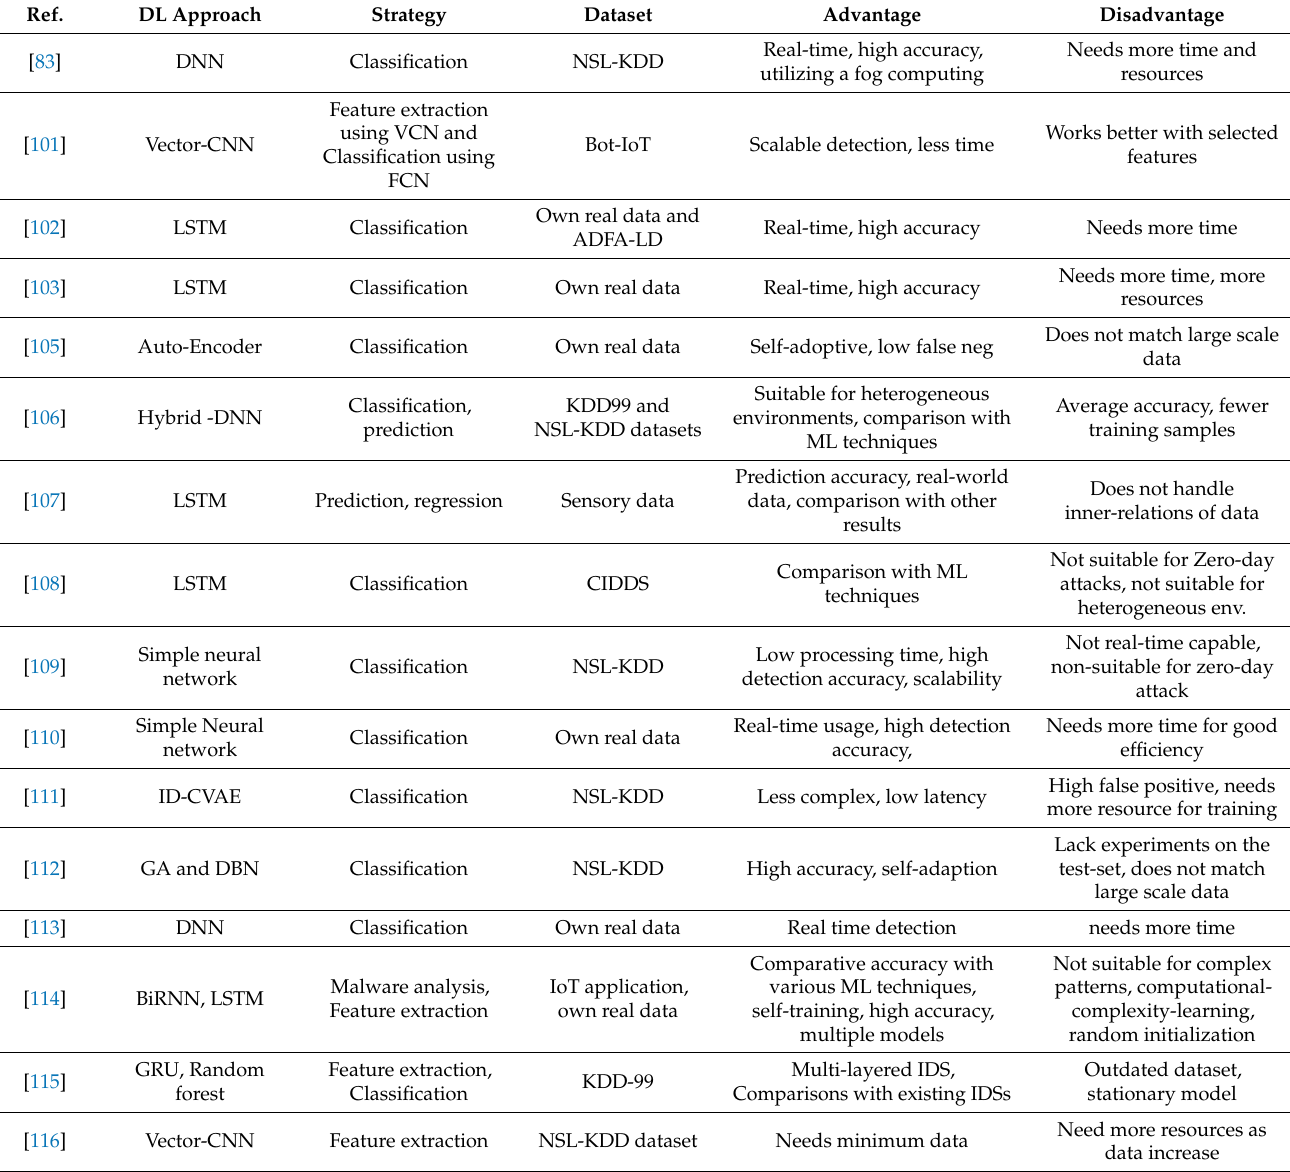
Table 4. Comparison of deep learning techniques that are used for anomaly-based IDSs in IoT.